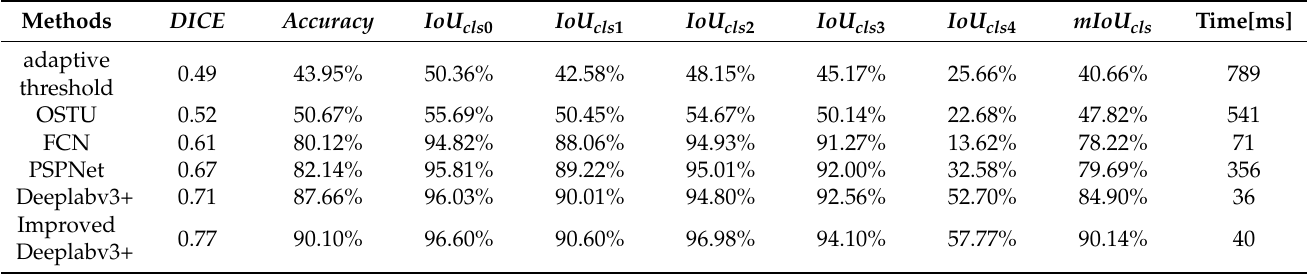
Table 4. Results of six models on composite